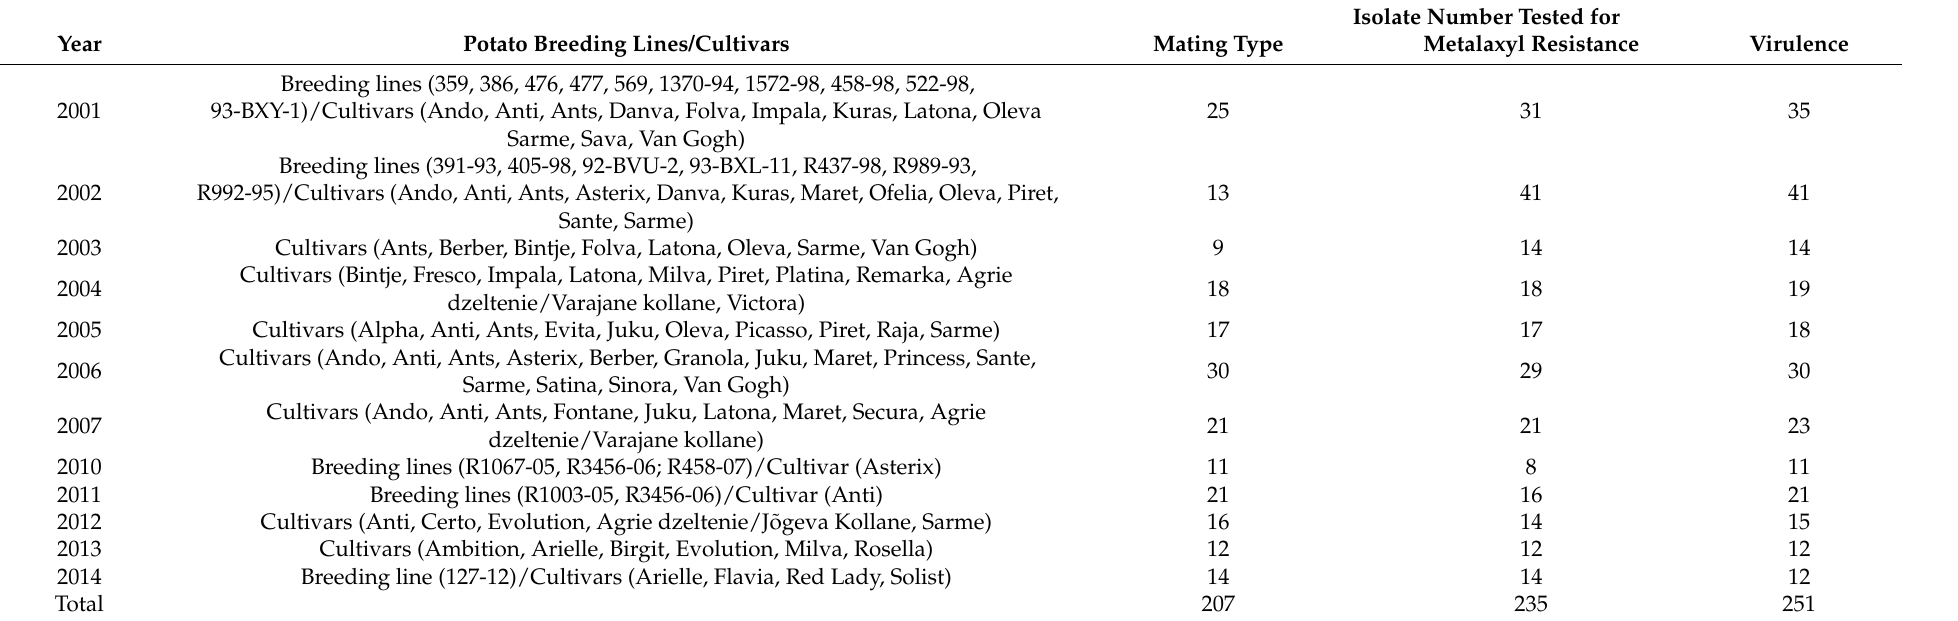
Table 3. Year of sampling, potato ( Solanum tuberosum ) cultivars studied, and number of Phytophthora infestans isolates tested for mating type, metalaxyl resistance, and virulence for strains collected from the potato breeding fields in Estonia during periods 2001–2007 and 2010–2014. Isolate Number Tested for Potato Breeding Lines/Cultivars Mating Type Metalaxyl